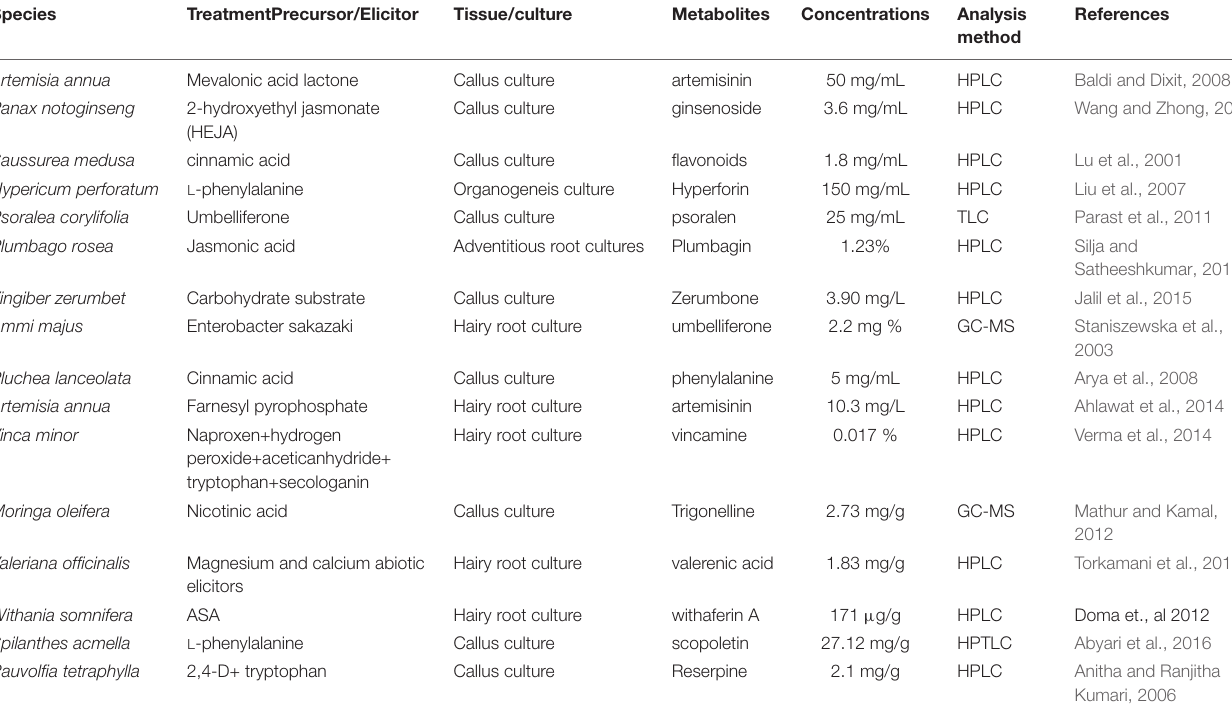
TABLE 2 | Comparative study on various precursor/ Elicitor treatment of different types of plant species.